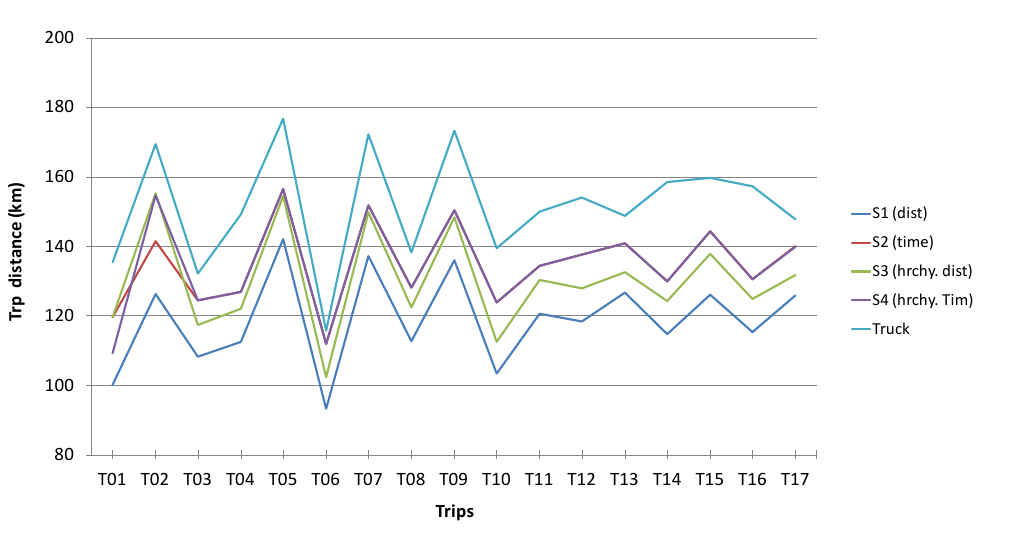
Figure 5. Comparison of travelling distance per trip under five different routing scenarios: shortest distance (S1), shortest time (S2), hierarchical shortest distance (S3), hierarchical shortest time (S4), and routes taken by the truck